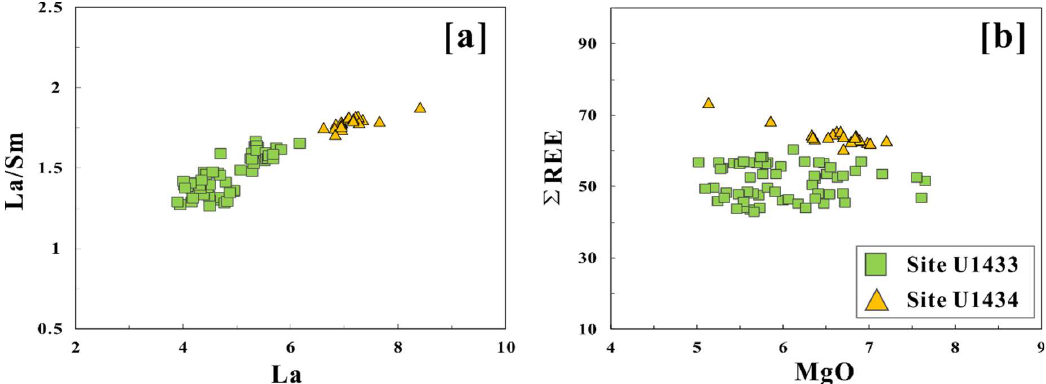
Figure 10. Diagrams of La/Sm versus La ( a ) and ΣREE versus MgO ( b ) for basaltic samples at Sites U1433 and U1434.